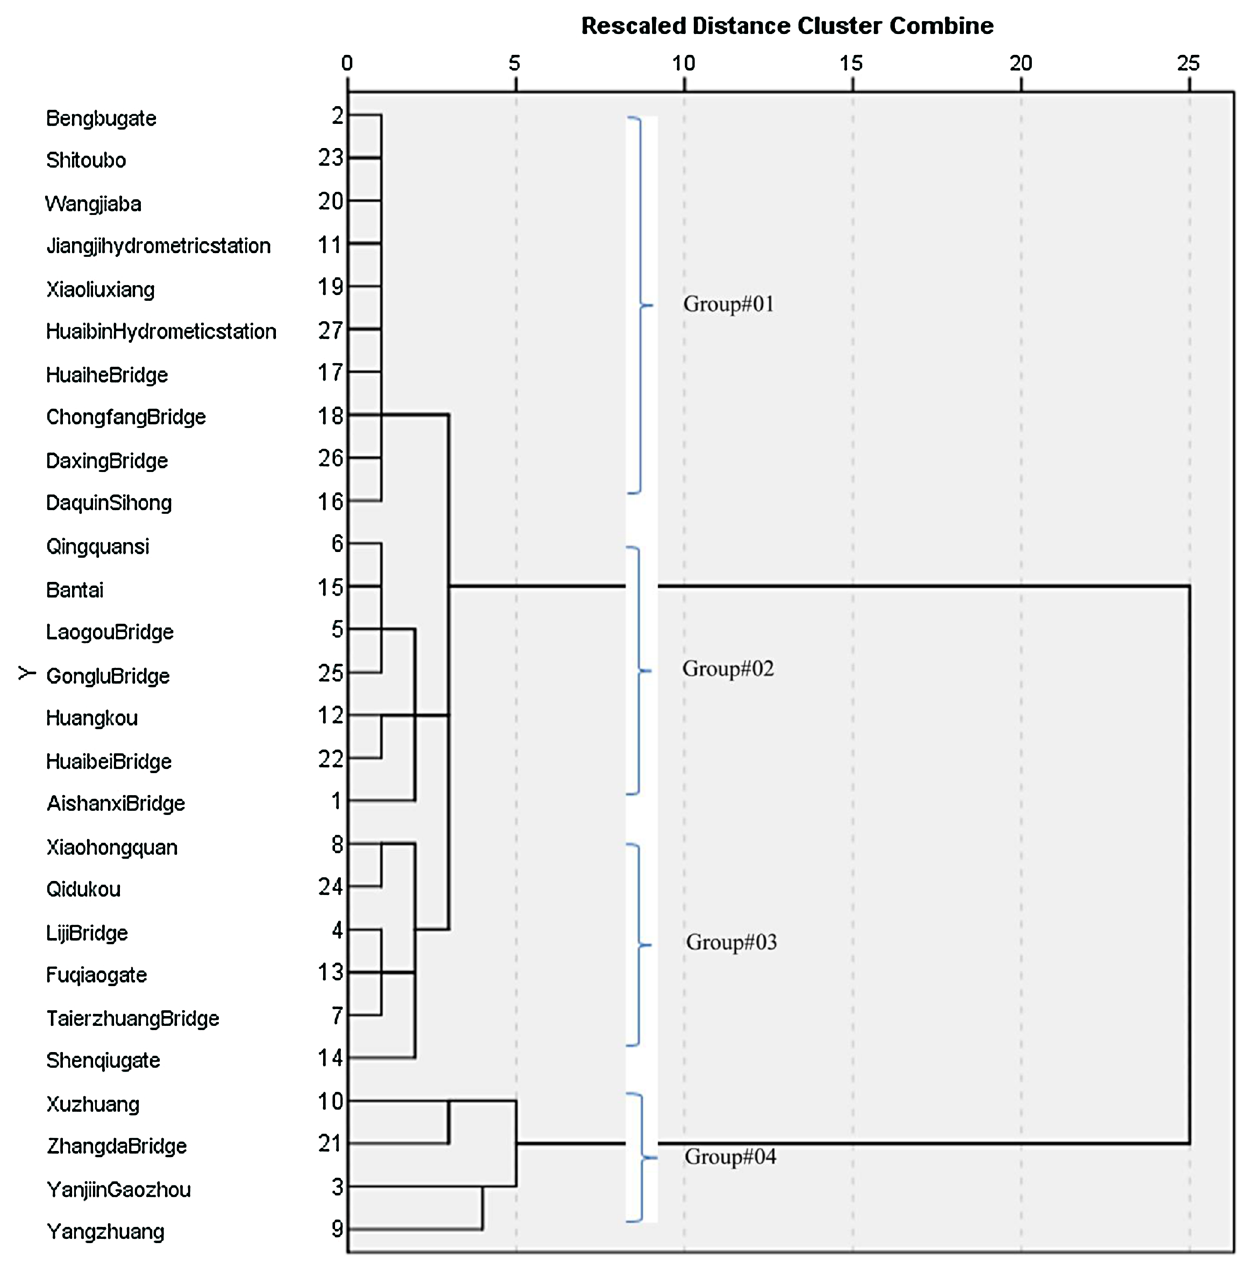
Fig. 2 Dendrogram of 27 water quality monitoring stations using Ward method based on water quality parameters of the Huaihe River